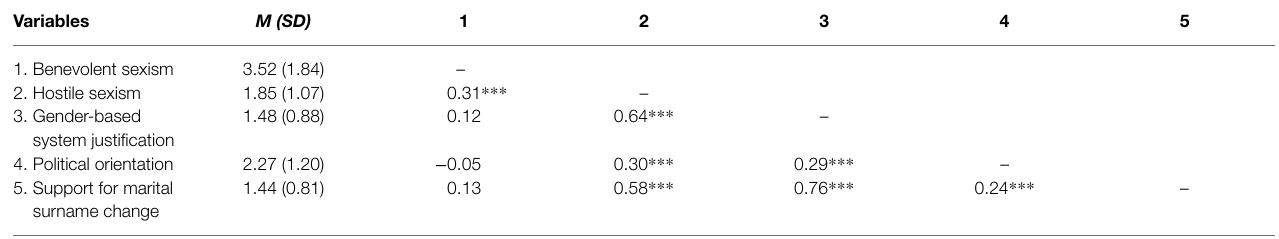
TABLE 1 | Means, SDs, and correlations among key variables (Study 1). Variables